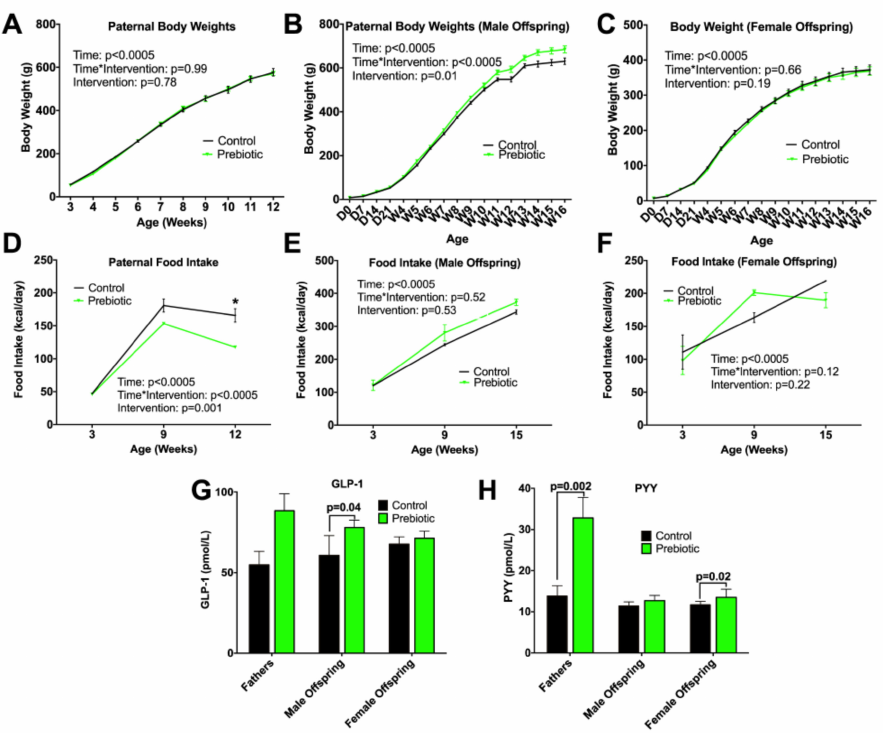
Figure 1. Body weight, food intake, and gastrointestinal hormones. Body weight of ( A ) fathers, ( B ) adult male offspring and ( C ) adult female offspring; food intake of ( D ) fathers, ( E ) male offspring ( F ) female offspring; ( G ) GLP-1 and ( H ) PYY. Food intake was analysed using independent samples Kruskal–Wallis tests. Values are means ± SEM, n = 8–13. In adult offspring, there was a significant